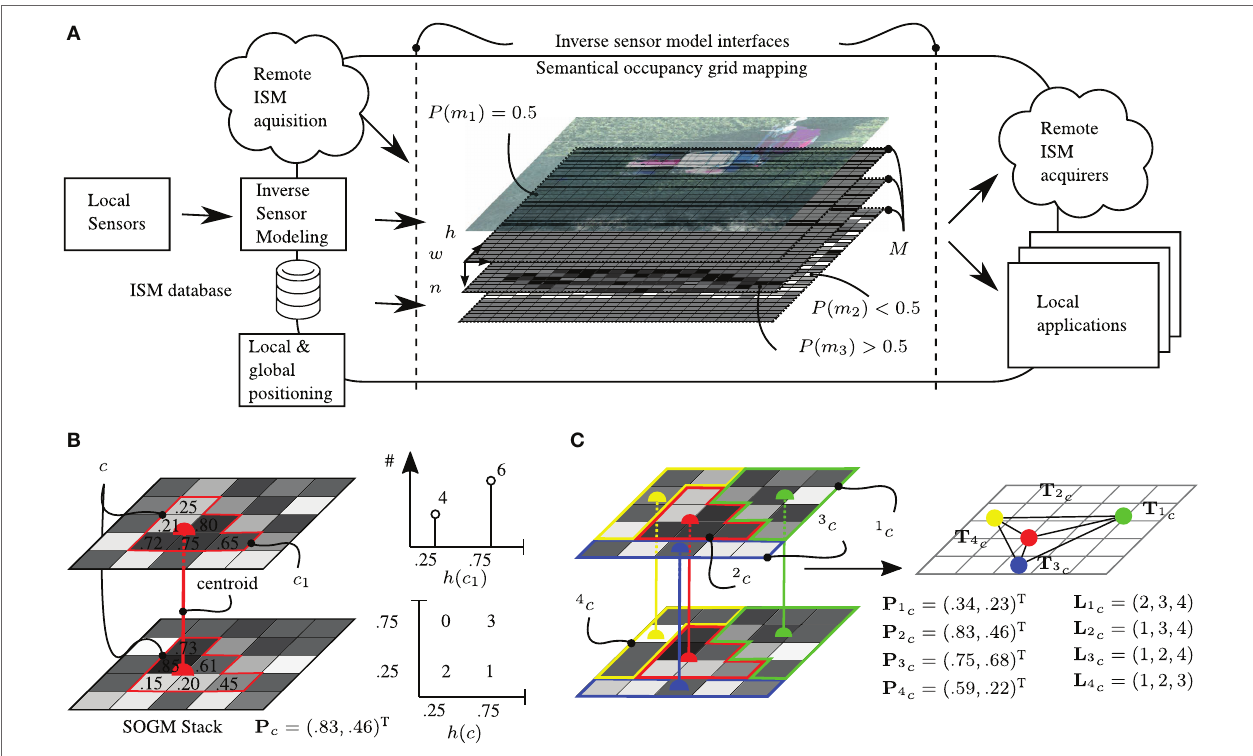
FIGURE 3 | Semantical OGM framework and supercell clustering. (A) Semantical occupancy grid mapping framework. (B) Supercell with N = 2 layers and corresponding histograms with K = 2 bins. (C) Conversion of supercells to a graph of centroids labeled with feature